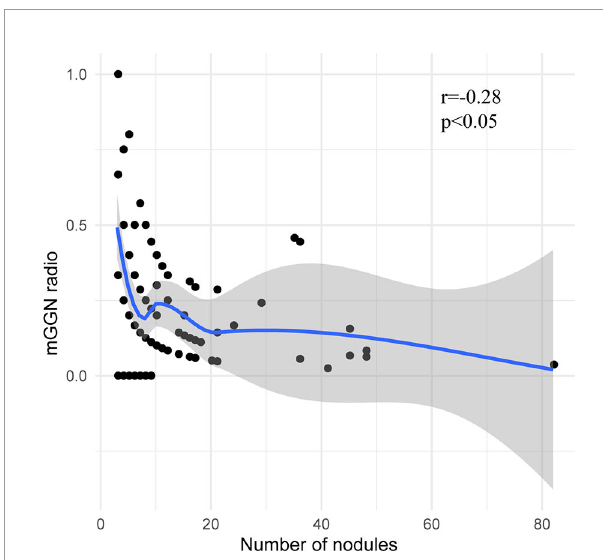
FIGURE 2 | The correlation between the proportion of mixed ground-glass nodules and the total number of nodules.